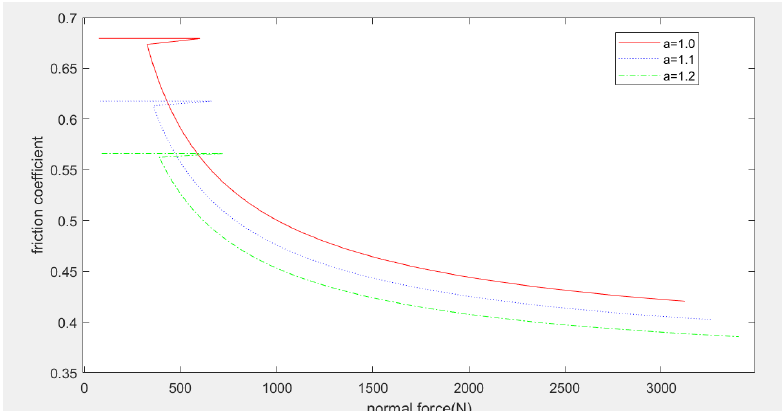
Figure 4. Friction coefficient versus normal force graph.